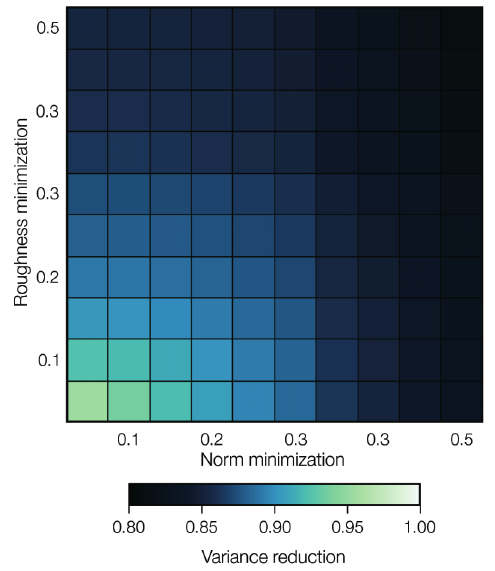
Fig. 8. Variance reduction of 35 s Love wave disper- sion from the Utrecht database, as a function of norm ( x -axis) and roughness ( y -axis) damping parameters.